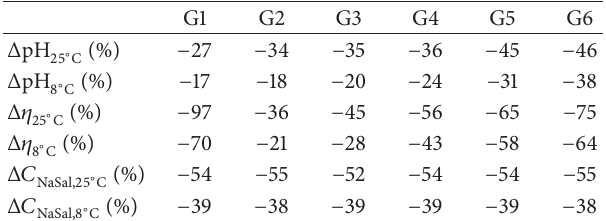
Table 3 for freshly prepared hydrogels and in Table 4